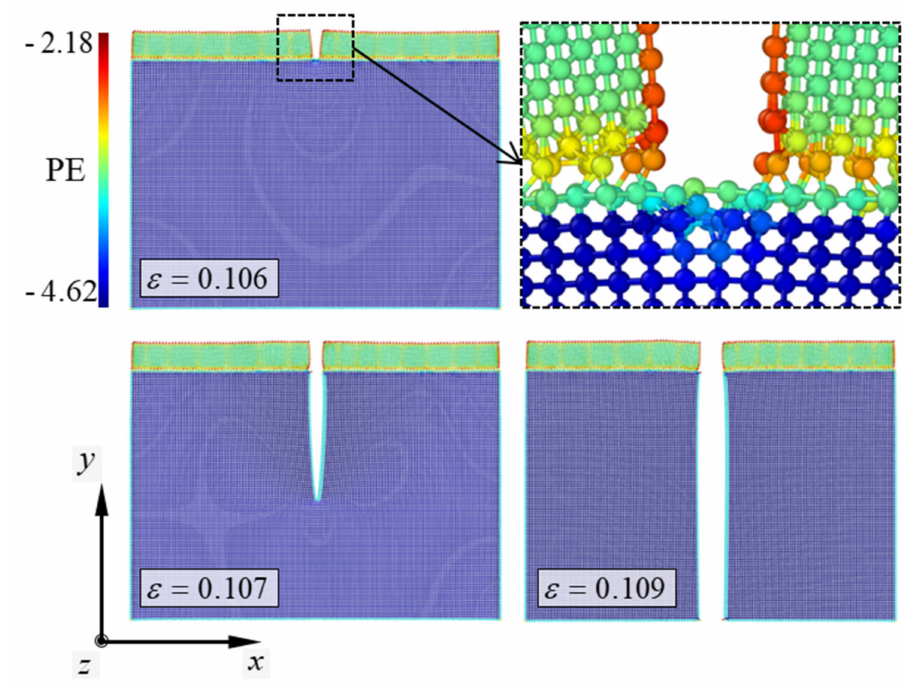
Figure 3. Atomic configurations depicting the fracture mechanism of the Al(110)/Si(110) model. The nanofilm thickness in the simulation model is approximately 3 nm. The PE indicates the atomic potential energy of the